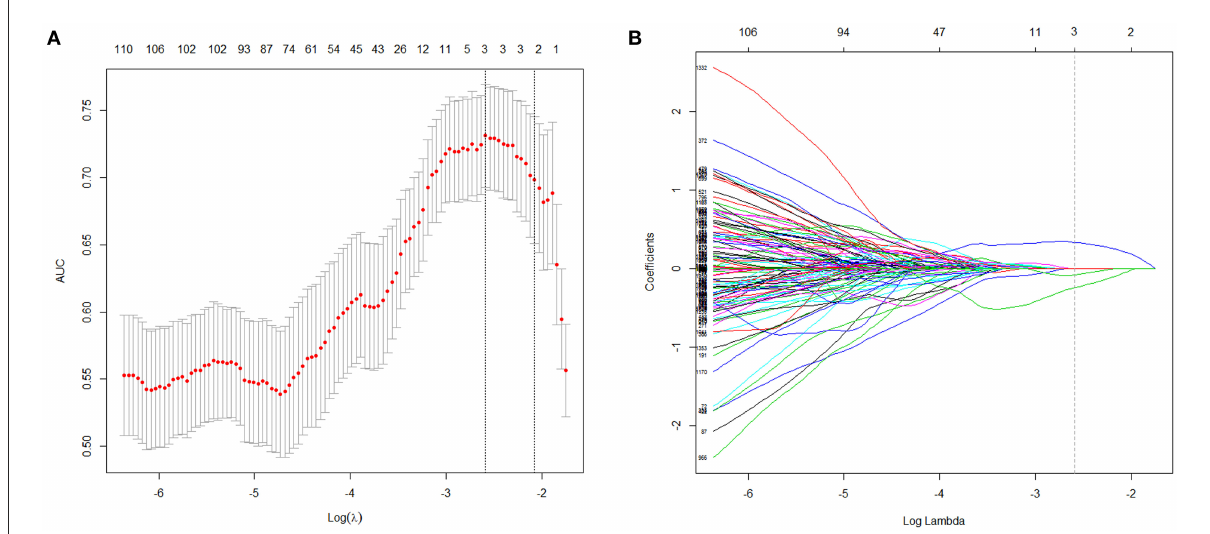
FIGURE2 Radiomics features selection with LASSO. This method minimized the sum of residues, with the sum of the absolute values of the selected features coefficients being not more than a tuning parameter ( λ ). (A) Tuning parameter ( λ ) selection in the LASSO model used 10-fold cross-validation via maximum criteria. The area under the curves (AUC) was plotted vs. log( λ ). The dotted vertical lines were drawn at the optimal values using maximum and 1-SE criteria. A log( λ ) value of − 2.59 was opted (maximum criteria). (B) LASSO coefficient profiles (y-axis) of the features. Each colored line represents the coefficient of each feature. The upper and lower x-axis represented the features number and the log( λ ), respectively. The dashed vertical line was drawn at the value chosen using 10-fold cross-validation in the log( λ ) sequence, and three features with nonzero coefficients were indicated. LASSO, least absolute shrinkage and selection operator; SE, standard